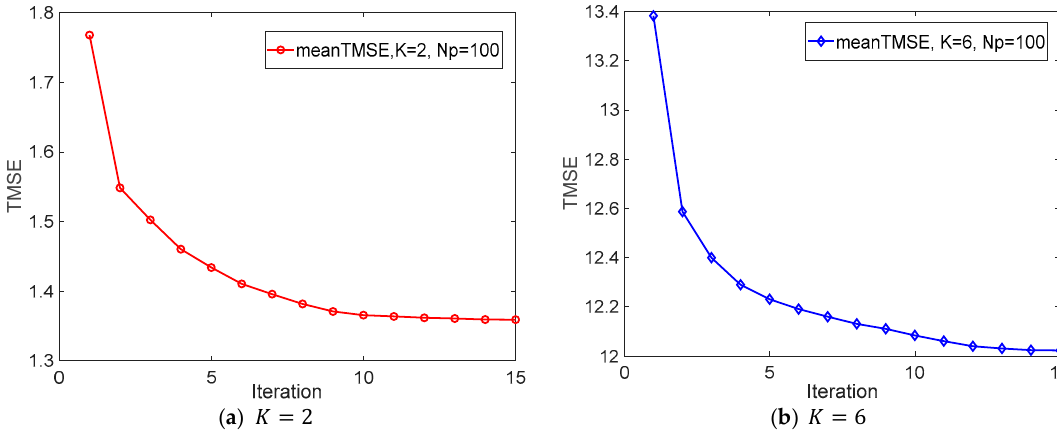
Figure 2. Total mean square error (TMSE) versus the number of iterations.